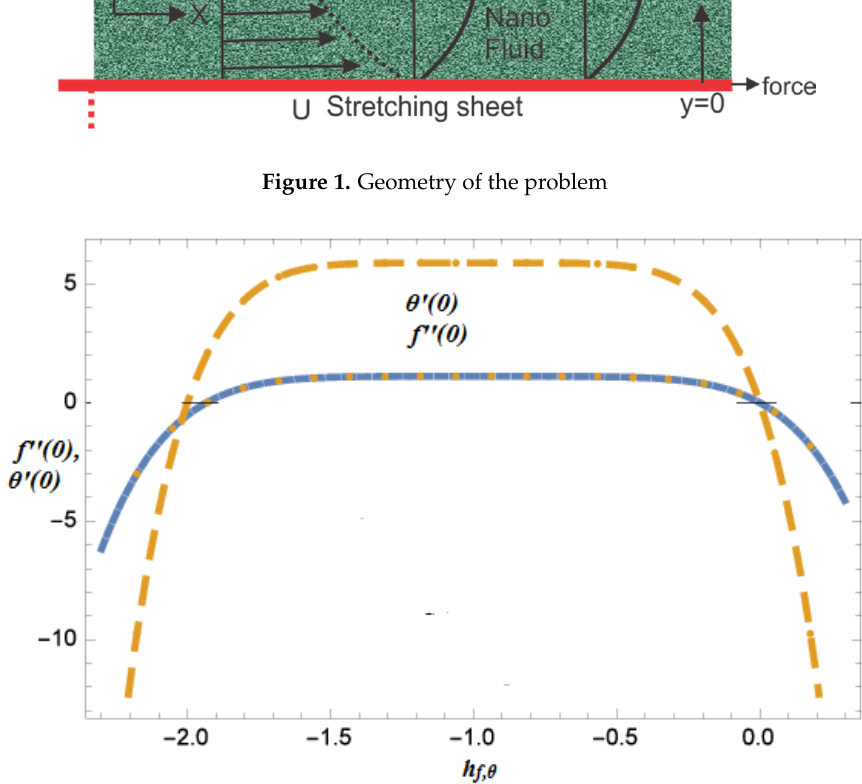
Figure 2. The combined graph of (cid:125) -curves f ”(0) θ ’(0), P r = 10, B r = 0.8, N r = 0.8, D u = 0.8, S c = 0.4, ε = 0.8, S r = 0.4, λ = 0.8, Λ = 1, β = 1, S = 0.3.